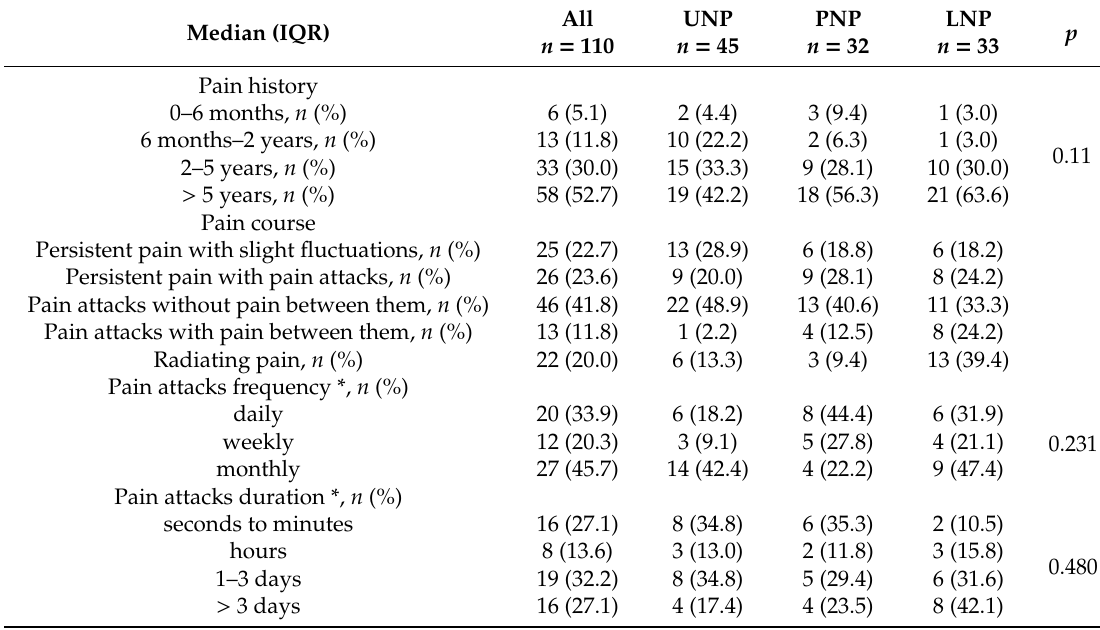
Table 2. Descriptive characteristics of pain in the hidradenitis suppurativa patient cohort according to PainDetect classification status: Unlikely Neuropathic Pain (UNP); Possible Neuropathic pain (PNP); Likely Neuropathic Pain